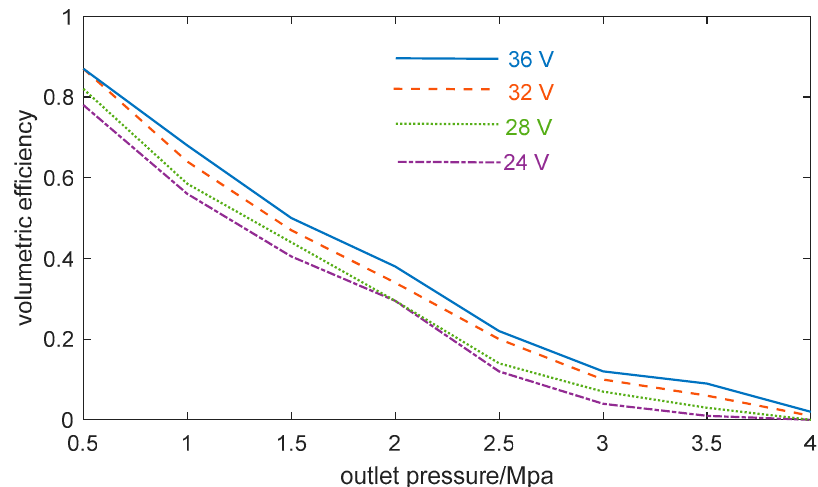
Figure 13. The influence of outlet pressure on volumetric efficiency.